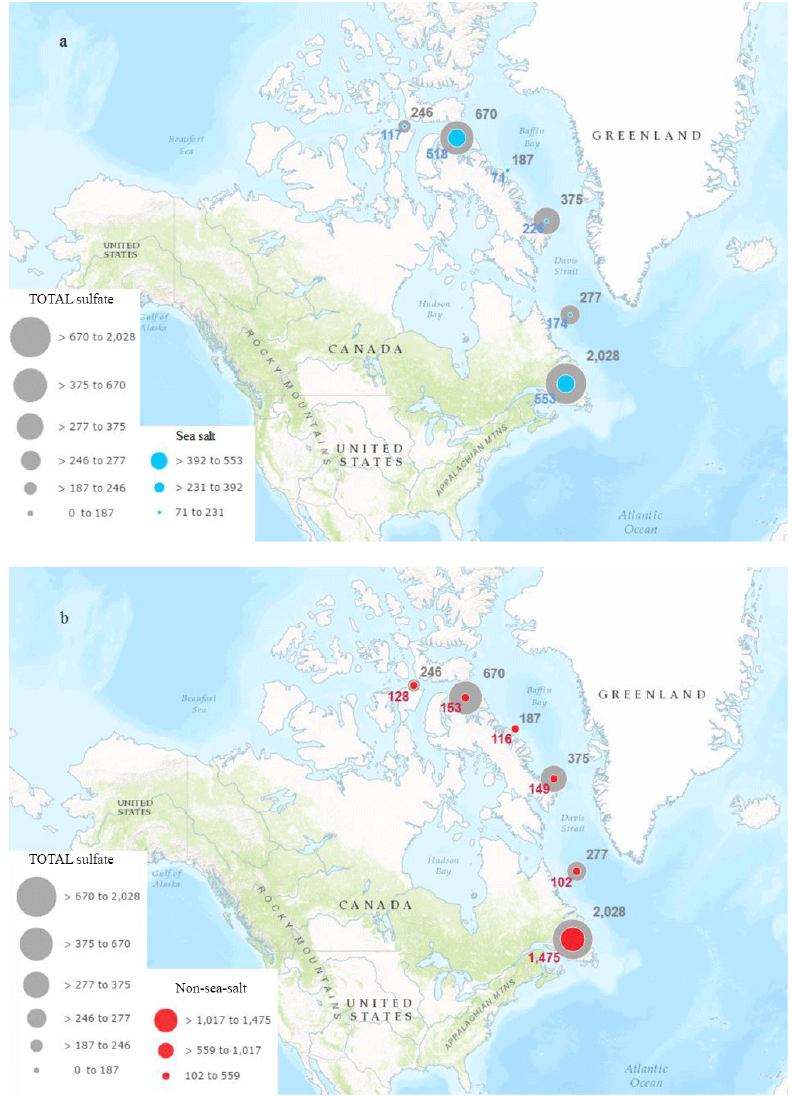
Figure 3. TOTAL sulfate, sea salt (a) and non-sea-salt (b) sulfate concentrations (ngm − 3 ) of aerosols on A > 7 . 2µm –F < 0 . 49µm filters. Numbers in the figure show TOTAL, sea salt and non-sea-salt sulfate concentrations (ngm − 3 ) in gray, blue and red colors,